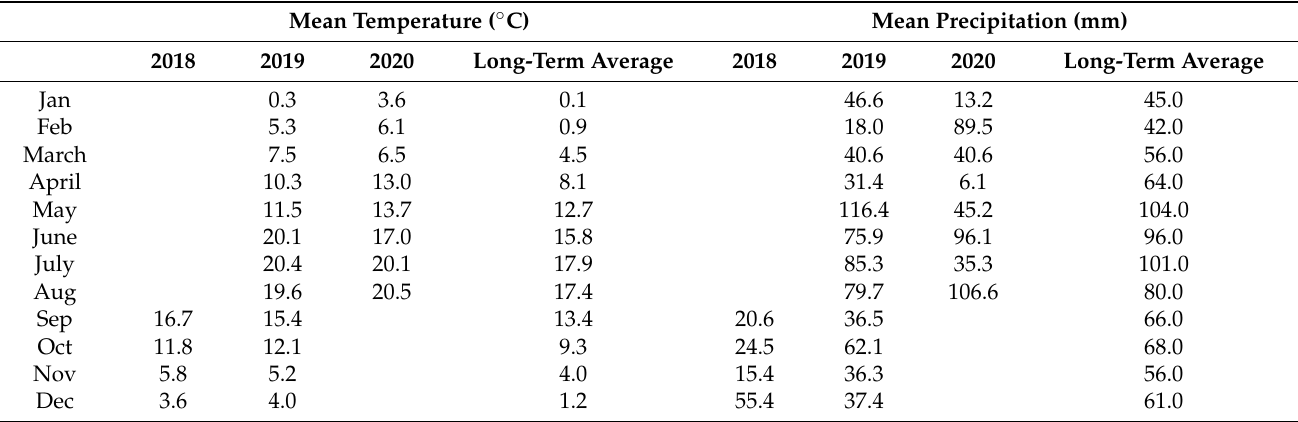
Table 1. Mean temperature and precipitation for the region of Hirrlingen, Baden-Württemberg from